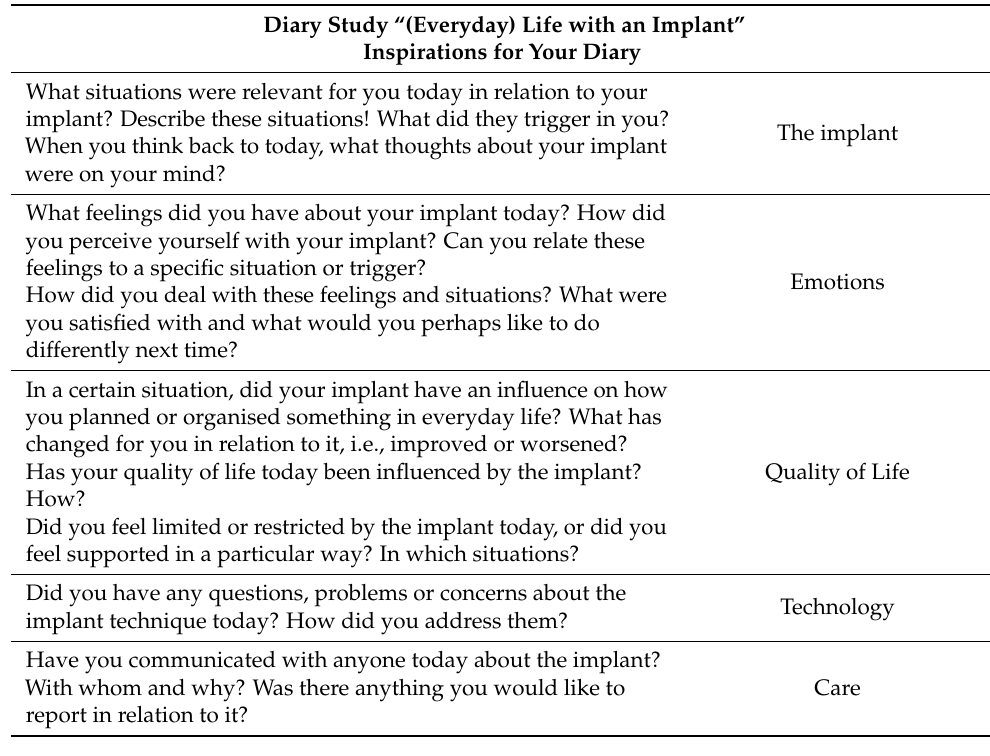
Table A2. “Inspiration sheet” for the diaries: adapted to each implant type. Diary Study “(Everyday) Life with an Implant” Inspirations for Your